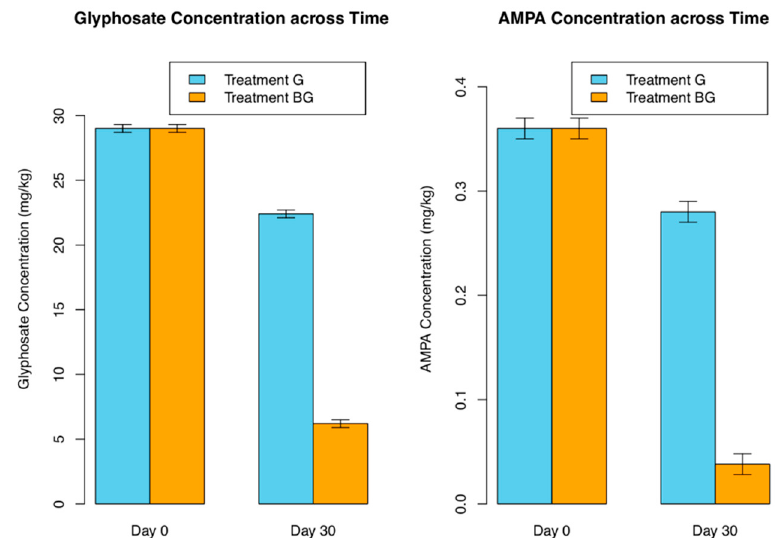
Figure 5. Determination of glyphosate and amidomethylphosphonic acid (AMPA) concentrations by UHPLC–MS / MS. Glyphosate and AMPA concentrations were determined at days 0 and 30 when the G and BG treatments were applied to the parcel. BG: bacteria-glyphosate, G: glyphosate (roundup 747). Results are shown as the mean ± SEM.